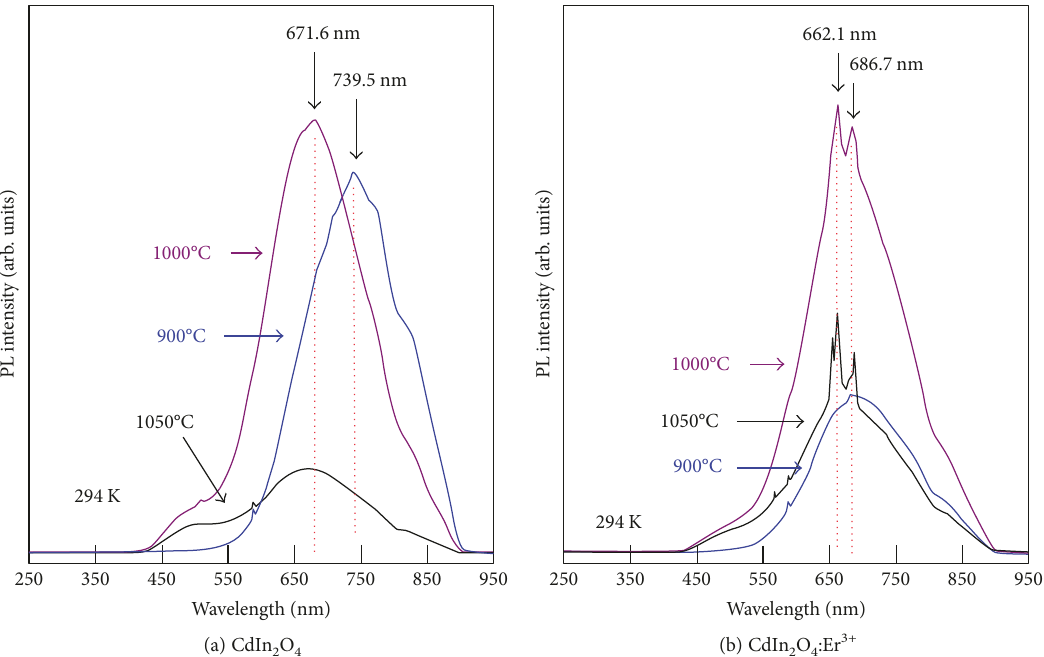
Figure 3: Photoluminescence spectrum of CdIn